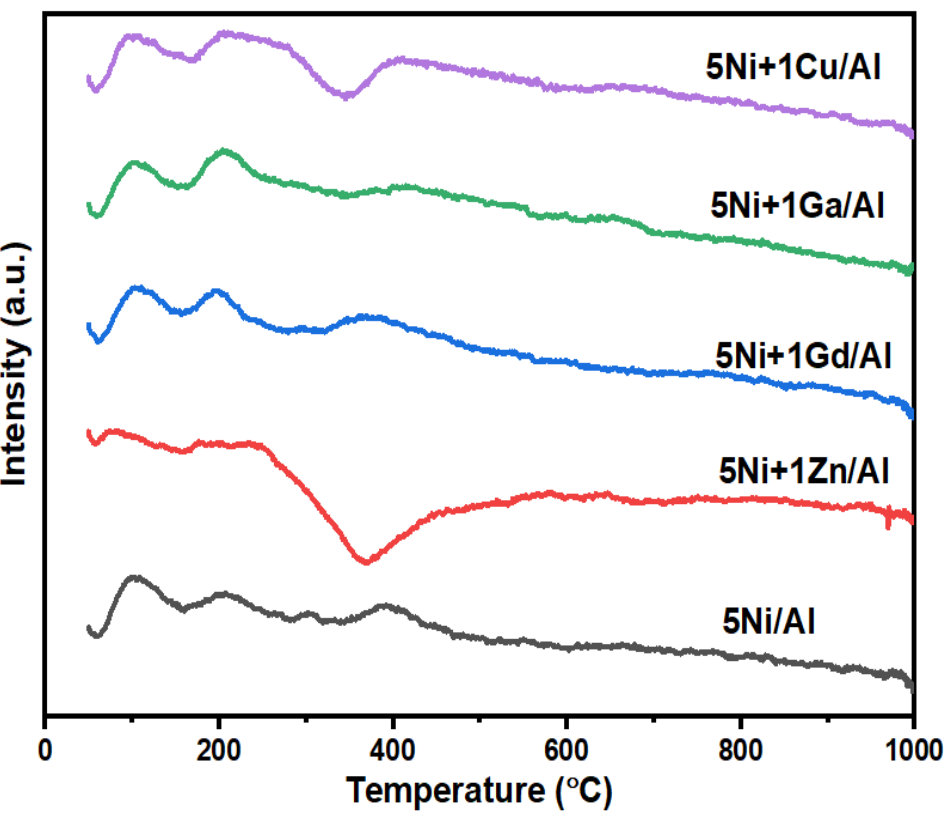
Figure 4. Temperature programmed oxidation (TPO) profiles of the used catalysts.